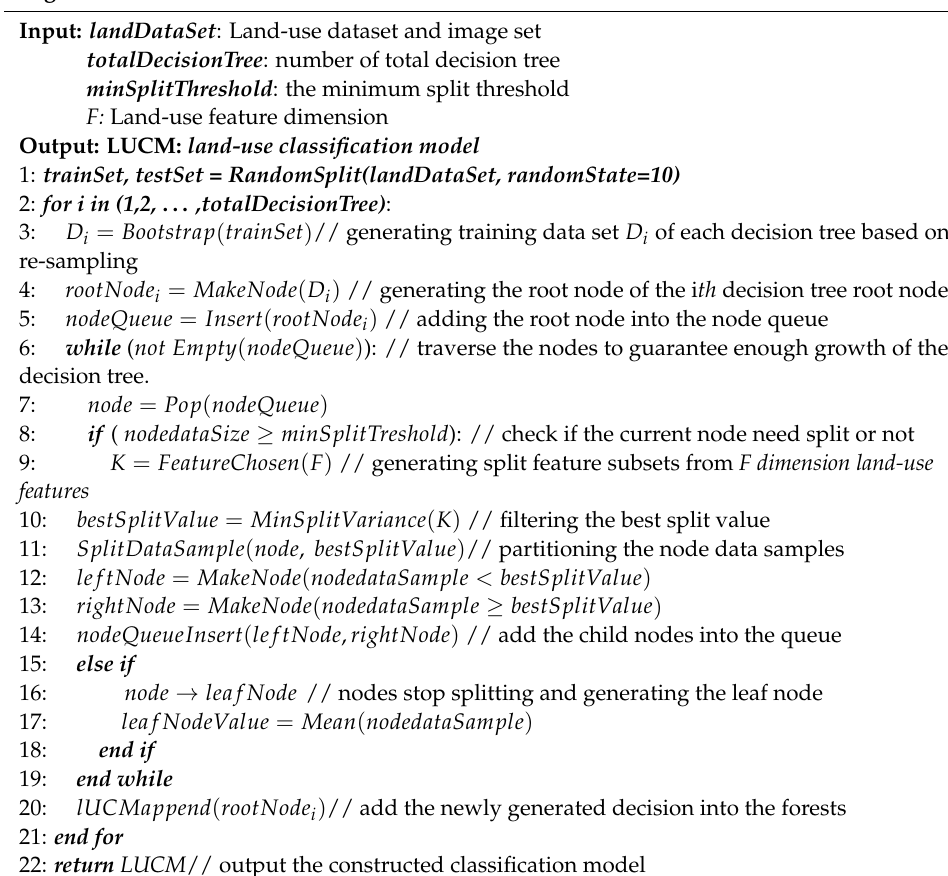
Algorithm 1 Random-Forests-Based Land-Use Classification